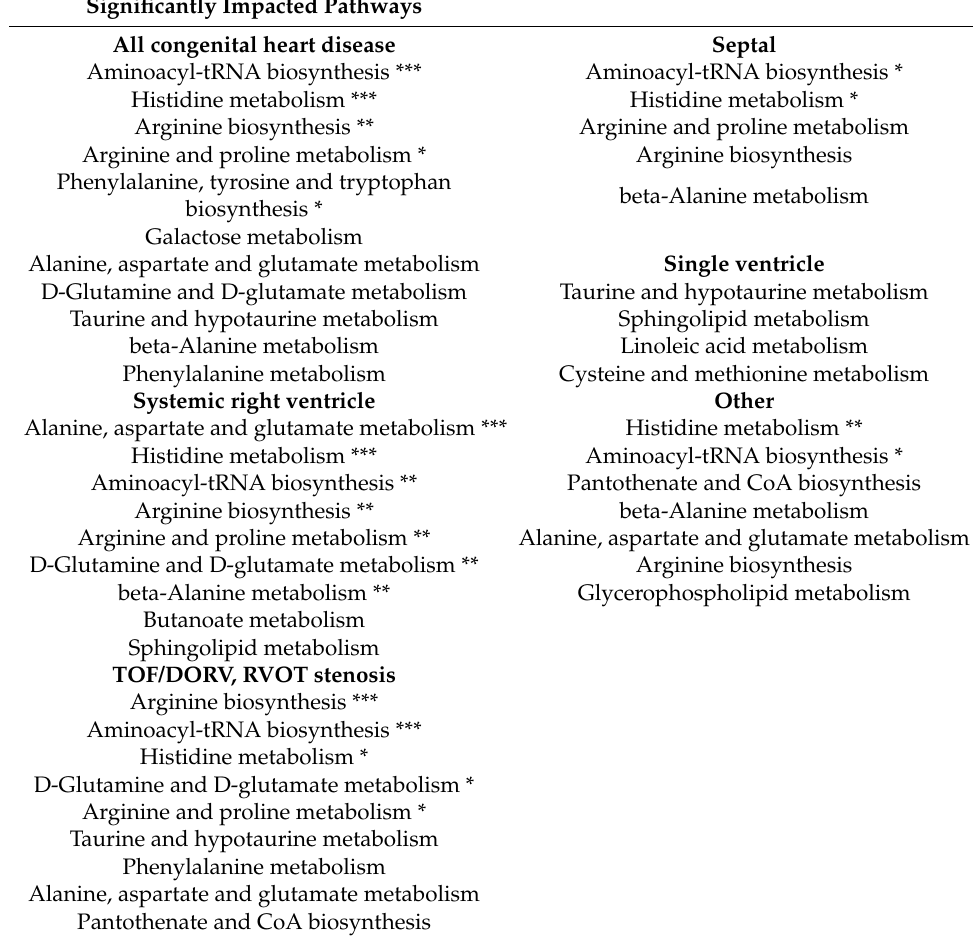
Table 2. Significantly impacted pathways stratified by category of ACHD diagnoses (*** FDR p <